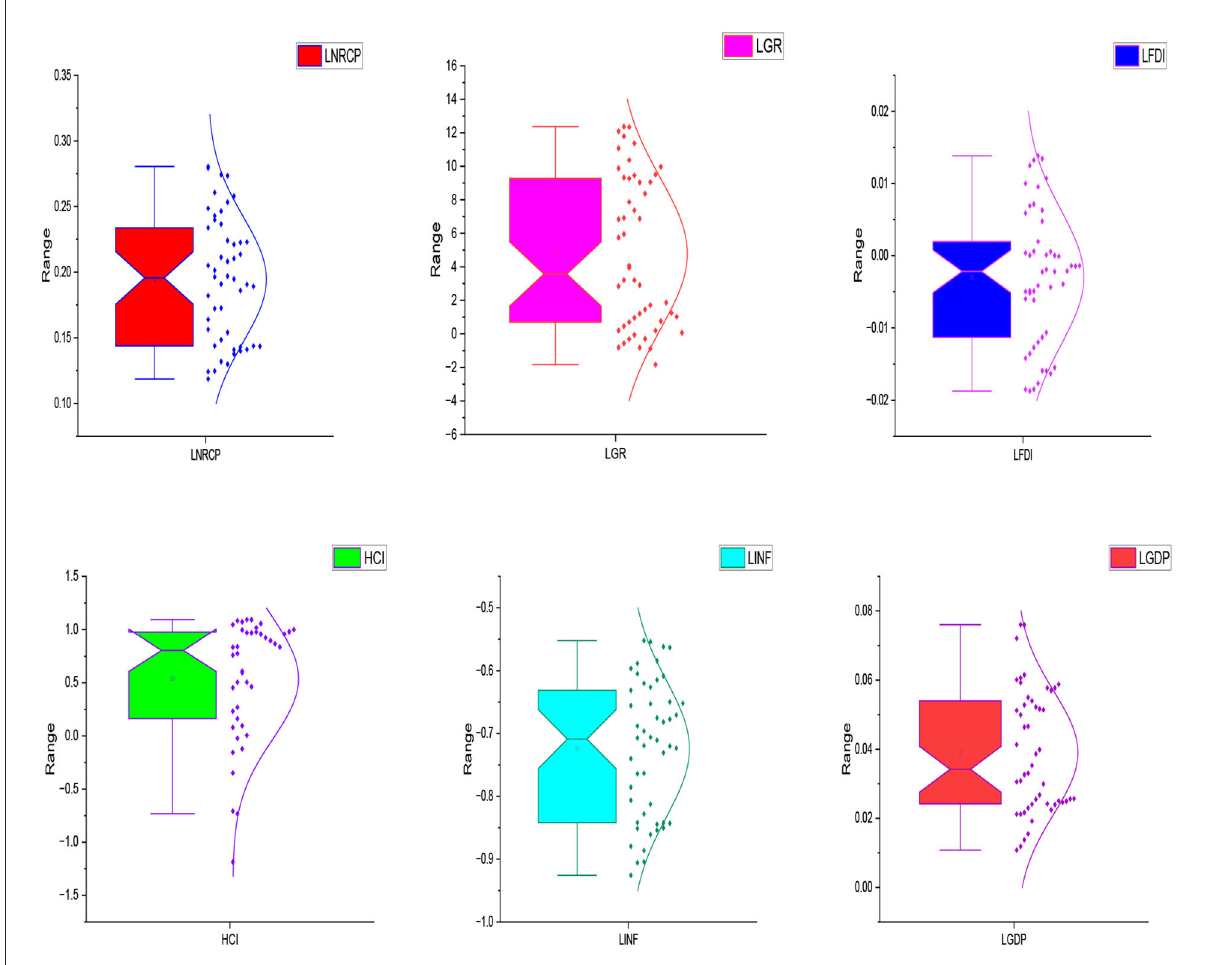
FIGURE1 Box plots of the selected